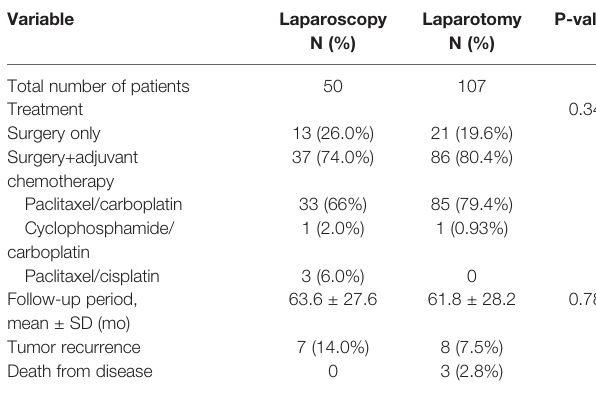
TABLE 3 | Postoperative treatment methods and survival outcomes. Variable Laparoscopy N